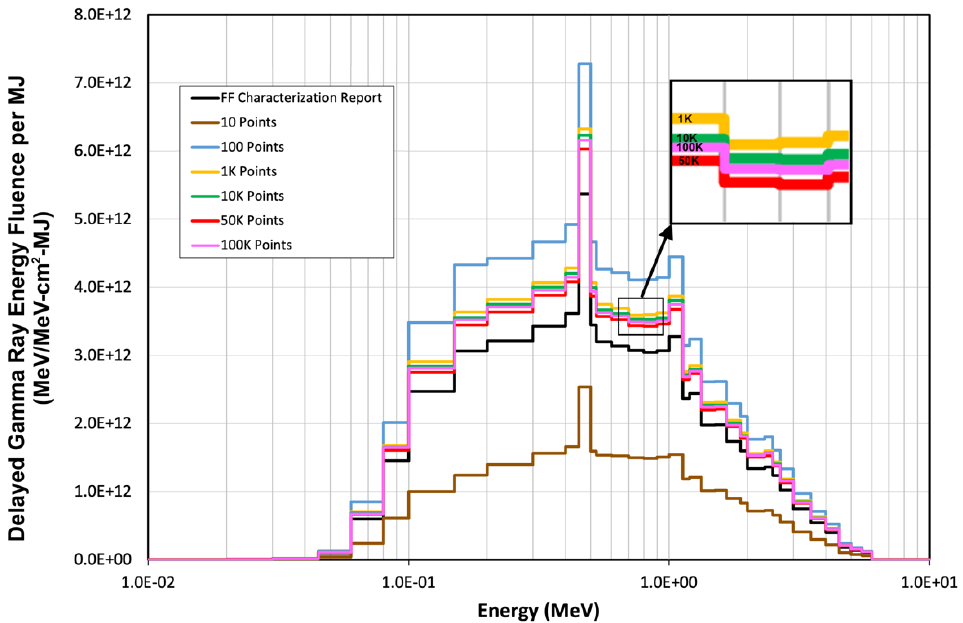
Figure 3. ACRR FF MCNP plots versus ACRR FF Characterization Report